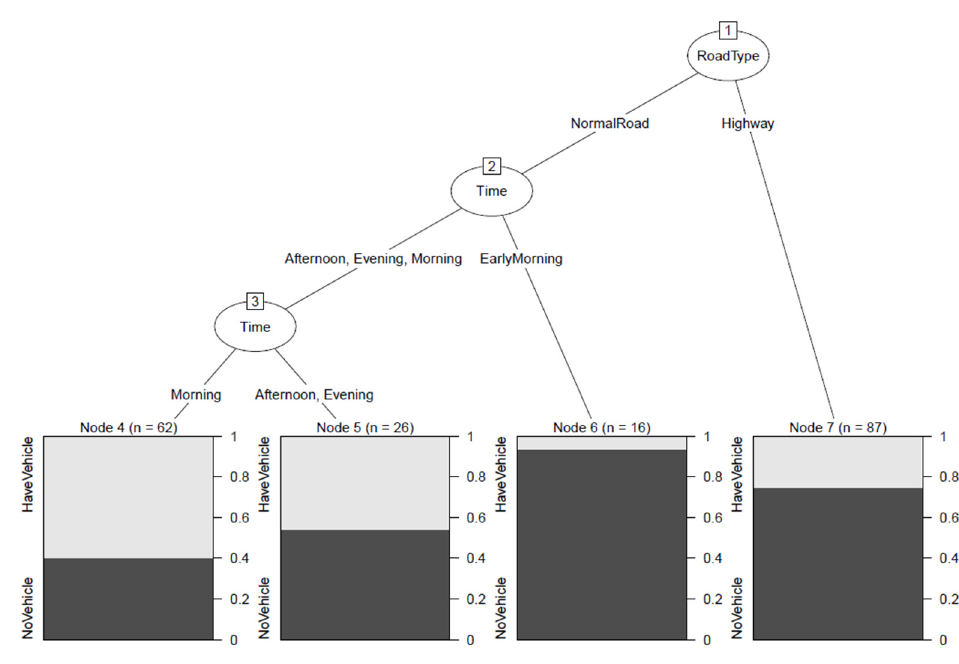
Figure 8. Decision tree from 191 videos.